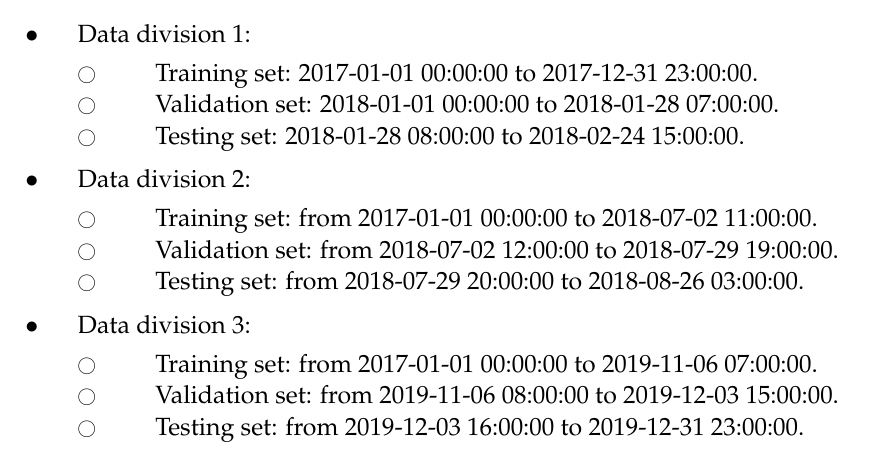
Figure 6. Power consumption for the data division 3.